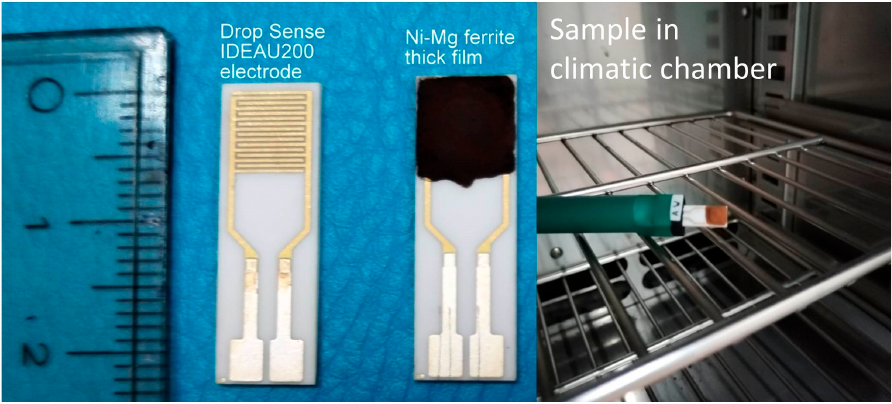
Figure 1. Ni-Mg ferrite thick film sample, used electrodes and setup in climatic chamber.